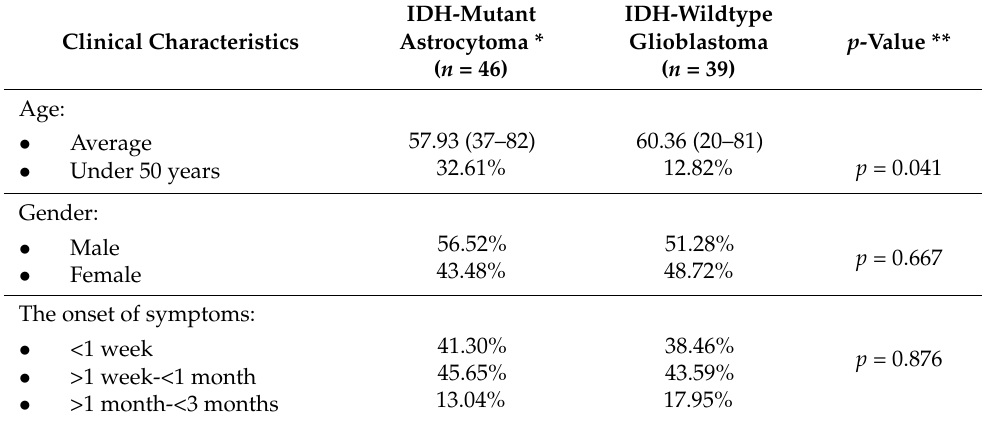
Table 1. Stratification by the diagnosis of the demographic elements, symptomatology, and personal pathological antecedents of the